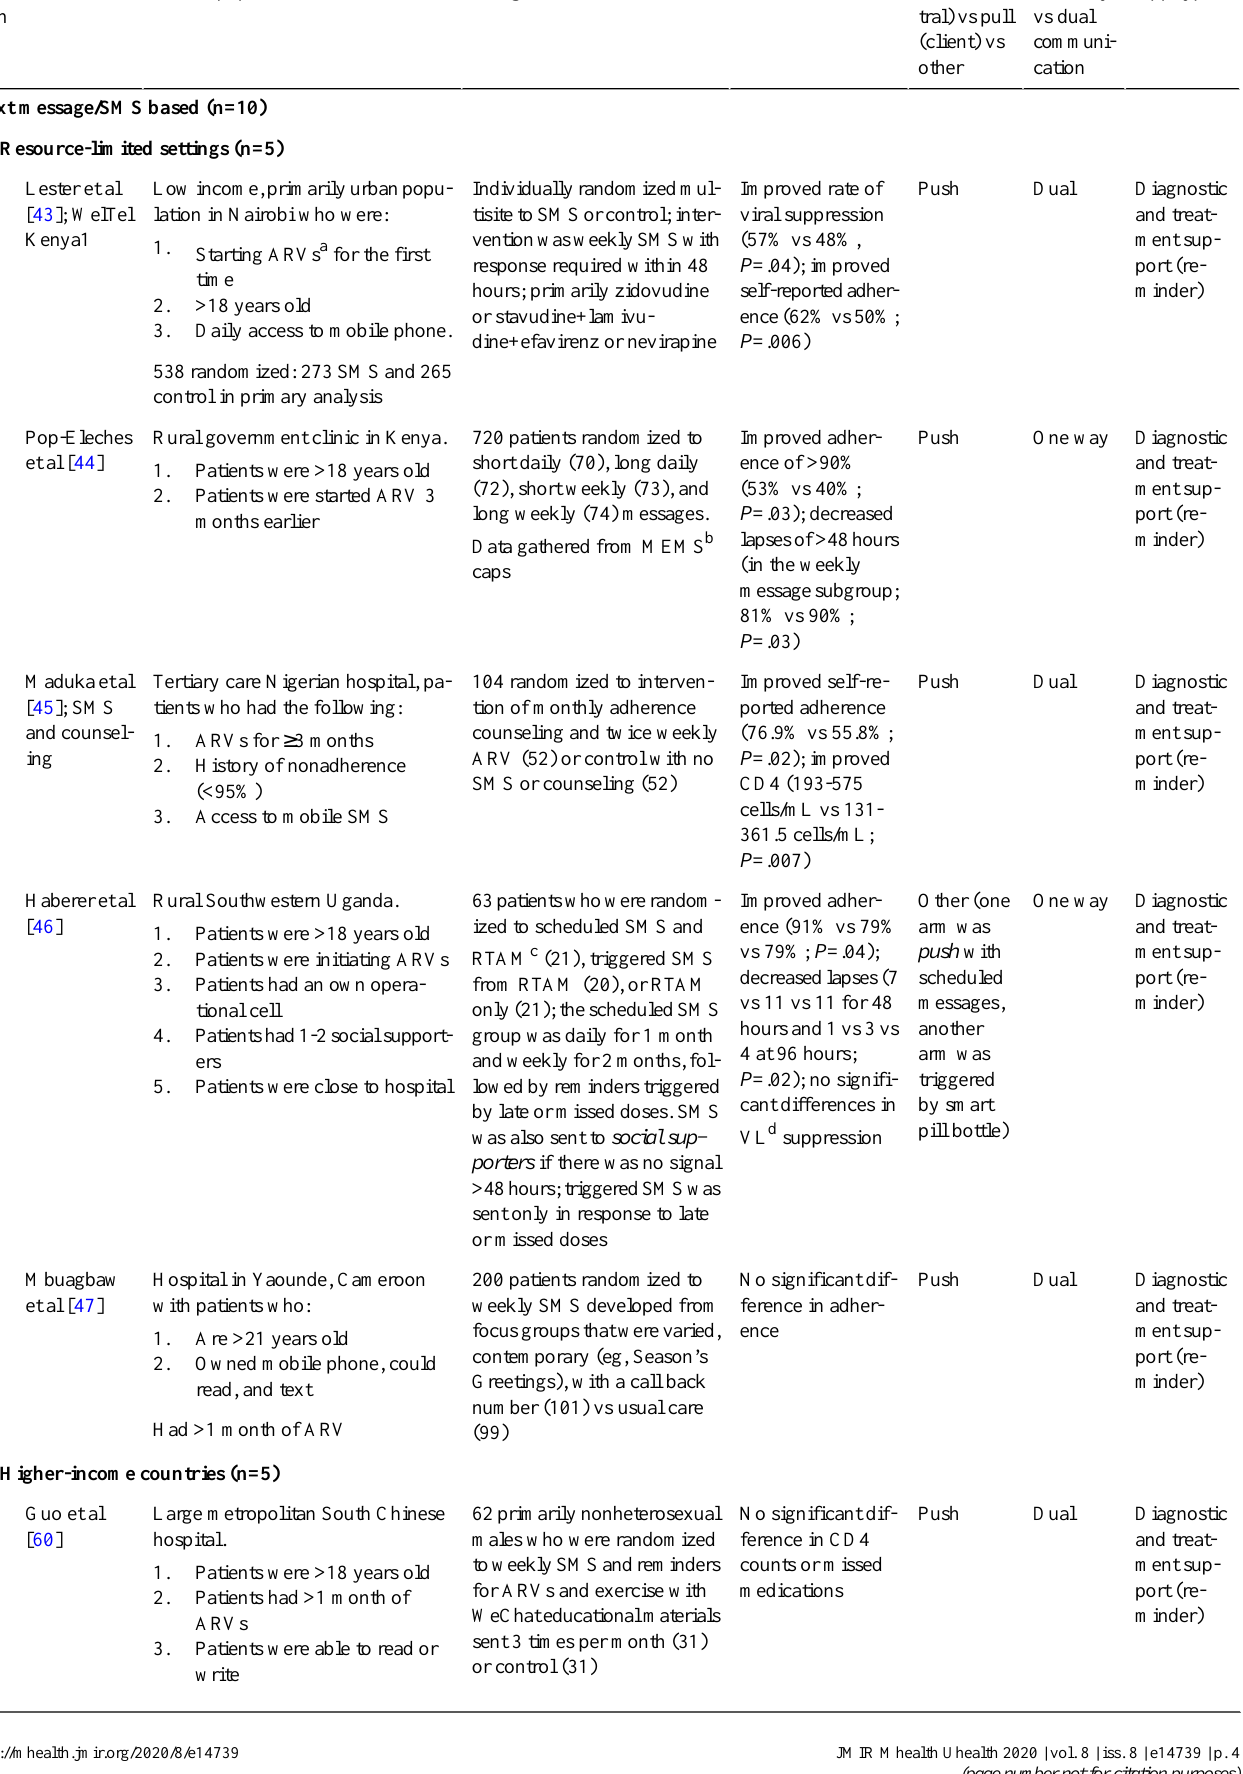
Table 1. Quantitative studies on the effects of mobile health and ubiquitous Health interventions in HIV management and antiretroviral adherence. otherEffectsDesignsPatient populationModes of